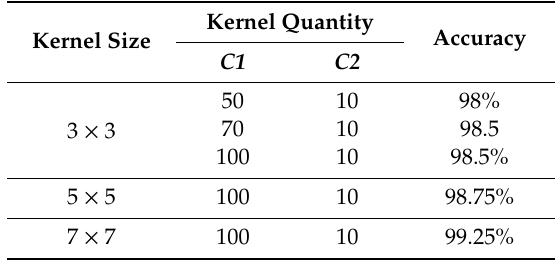
Table 2. Experiment results of di ff erent CNN network structures after the